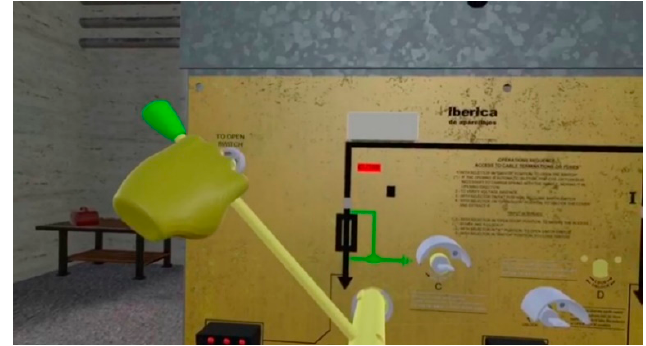
Figure 7. Unlocking a door containing fuses in the high-voltage cell simulation.